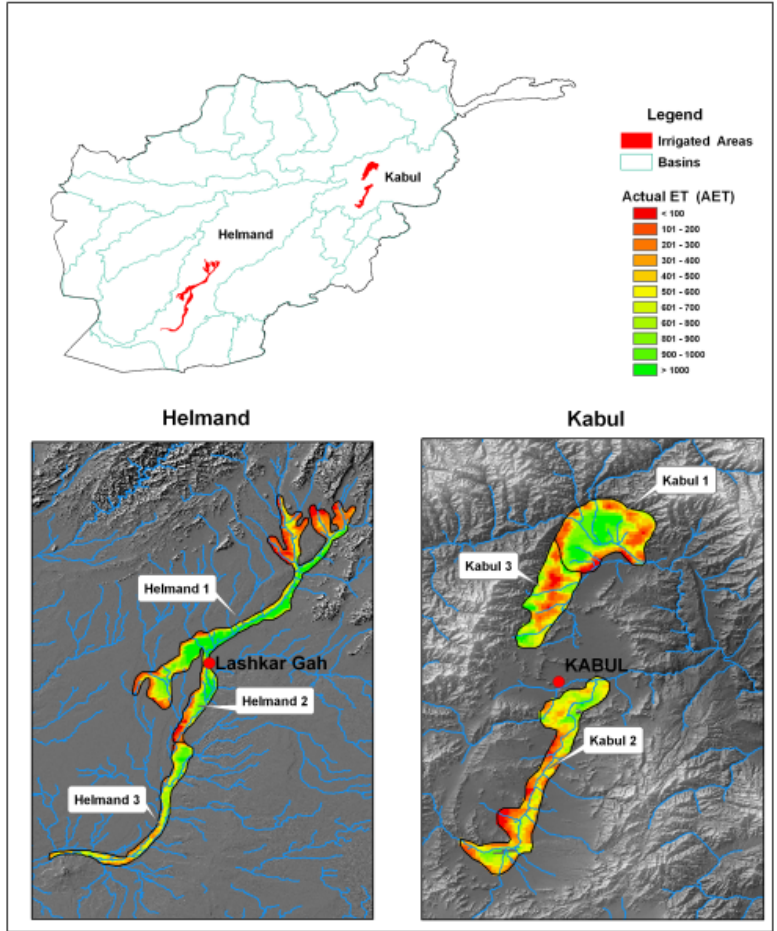
Figure 1. Study sites showing the irrigated fields in the Helmand and Kabul drainage basins. Enlarged